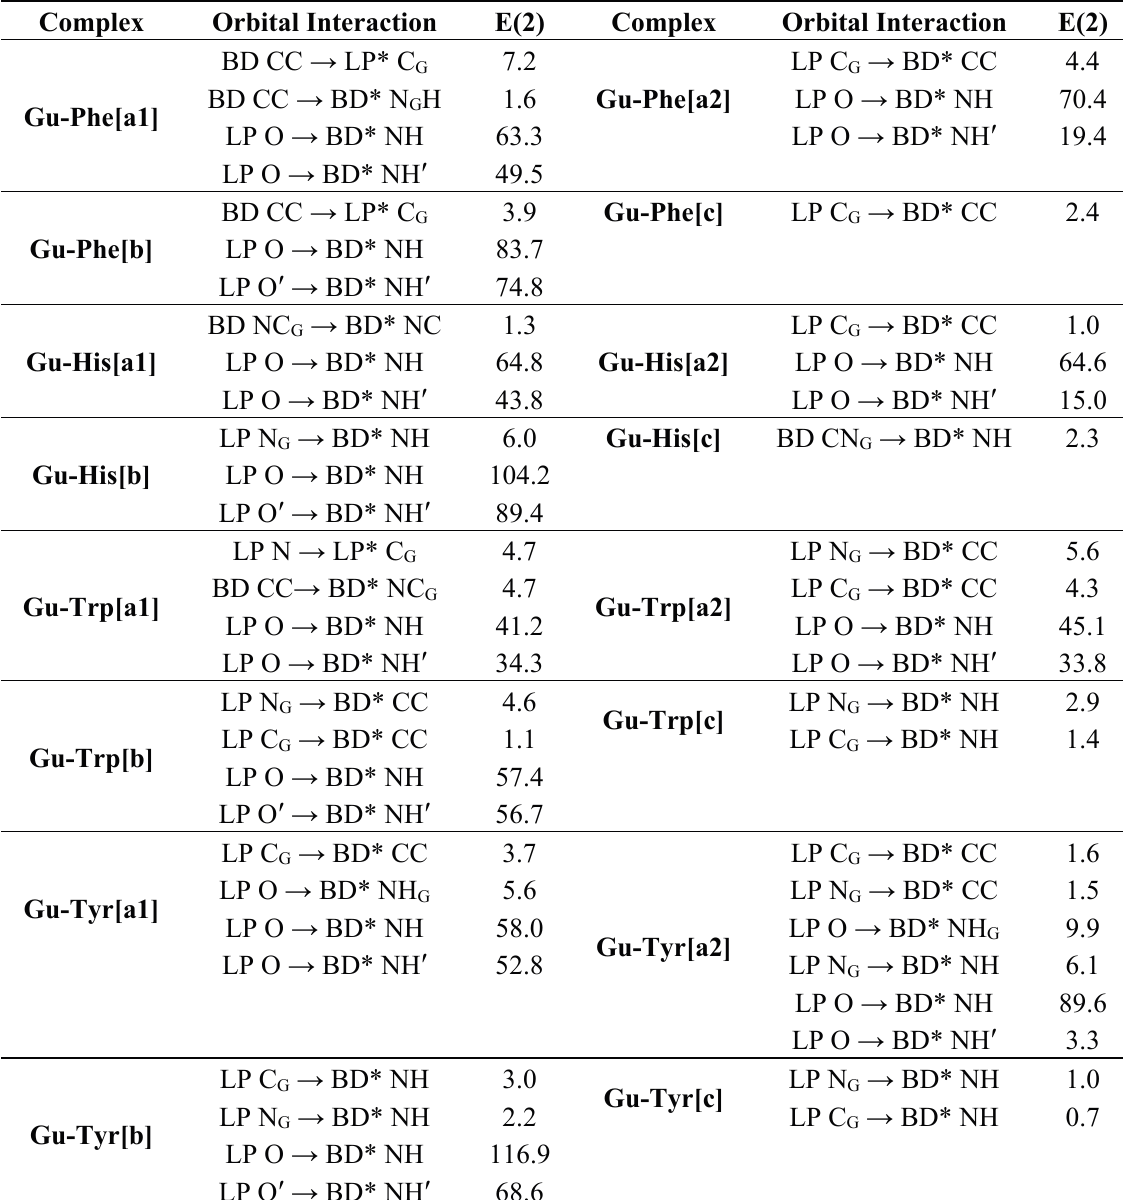
Table 3. Orbital energy [E(2), kJ·mol − 1 ] of the complexes studied at